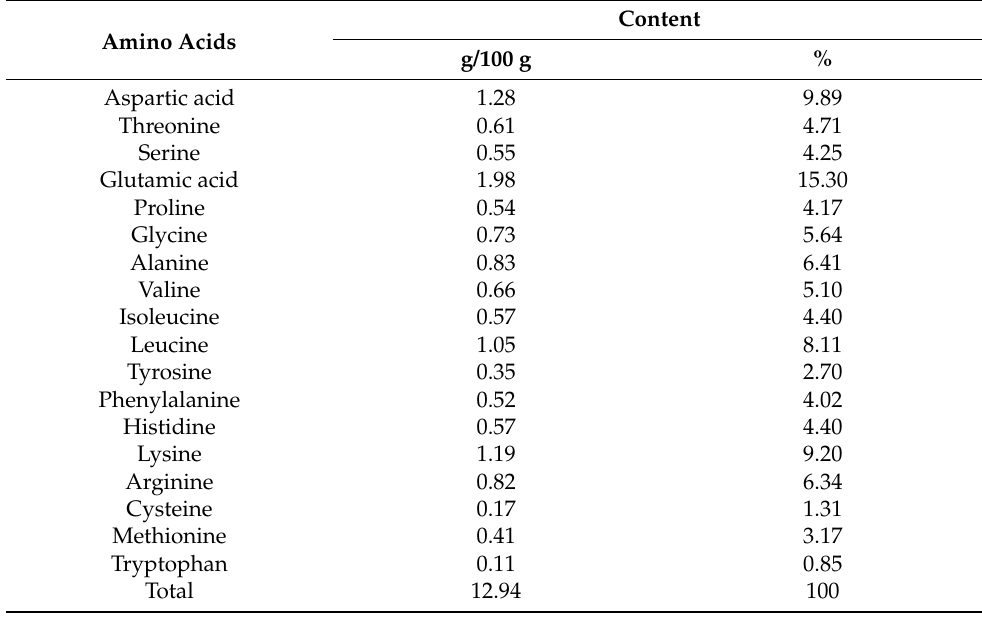
Table 8. Amino acid profile of braised mackerel with radish.